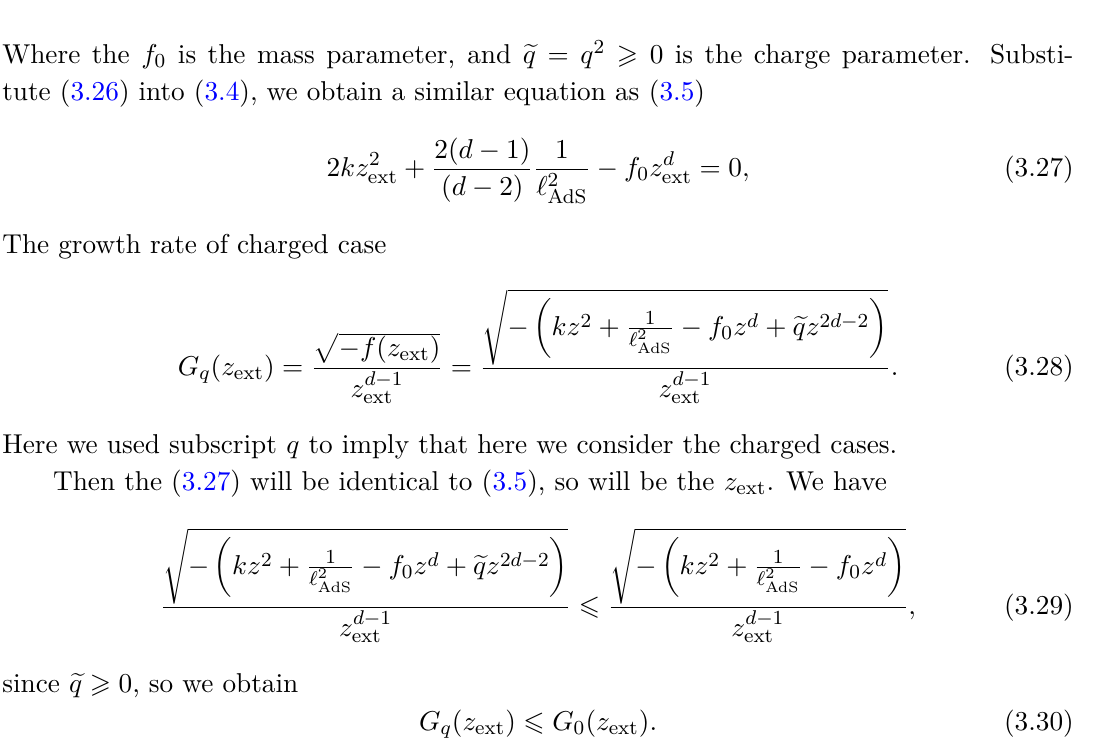
Figure 8 . For ‘ AdS = 1 , the vertical axis represents G ( z ext ) /Gp ( z ext ) and the horizontal axis represents T